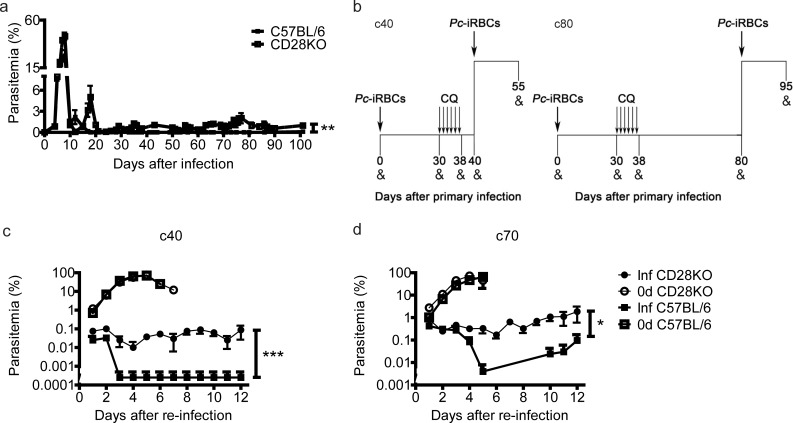
Parasitemia in C57BL/6 and CD28KO mice during primary and secondary Pc infections.(a) Parasitemia curves in mice infected intraperitoneally (i.p.) with 1 x 106
Pc-iRBCs. (b) The experimental design for the secondary infections. Reminiscent parasitemia was eliminated by treating 31 to 38 days post-infection (p.i.) mice with chloroquine (CQ). At days 40 (c40) or 80 (c80) p.i., mice were challenged with 1 x 108
Pc-iRBC. Experimental analyses were performed when indicated (&). (c) Parasitemia curves after secondary infection in c40 mice and age-matched controls (0d). (d) Parasitemia curves after secondary infection in c80 mice and age-matched controls (0d). In a, c and d, the significant differences (*p<0.05, **p<0.01, ***p<0.001) between the indicated groups are shown. Data from three independent experiments (n = 5–7, mean ± standard error mean—SEM) is shown.